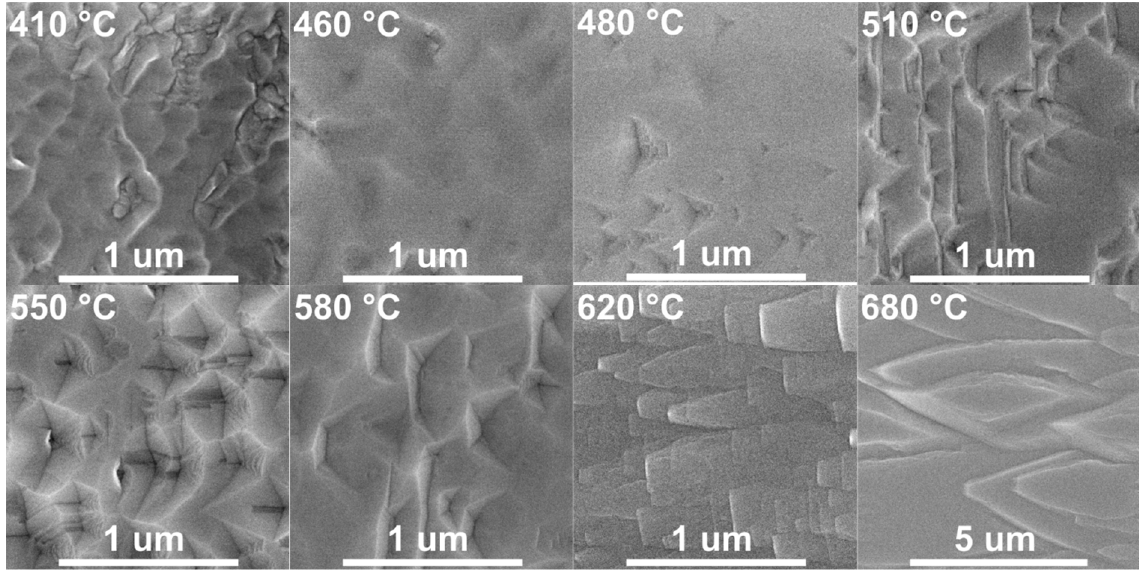
Figure 1. SEM of GaAs:Si (110) films formed at different growth temperatures and γ = 40–60. Height maps of the surface of the samples measured by AFM are shown in Figure 2.